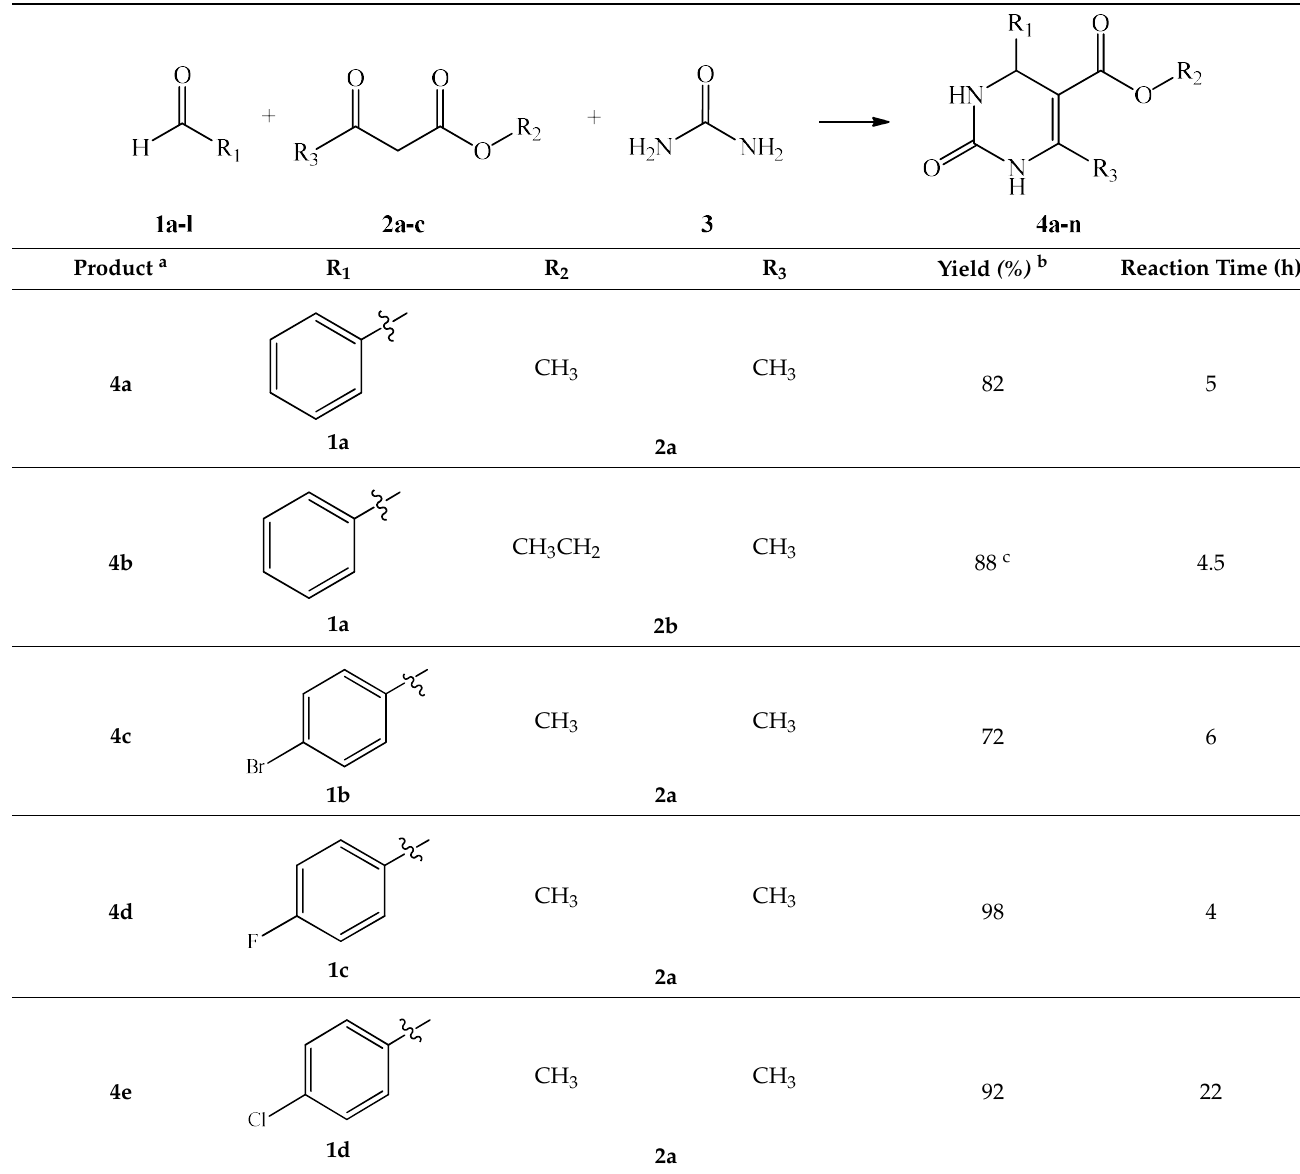
Table 3. Yields and reaction times for the Biginelli reaction involving aldehydes ( 1a-l ), β -ketoesters ( 2a-c ) and urea ( 3 ).